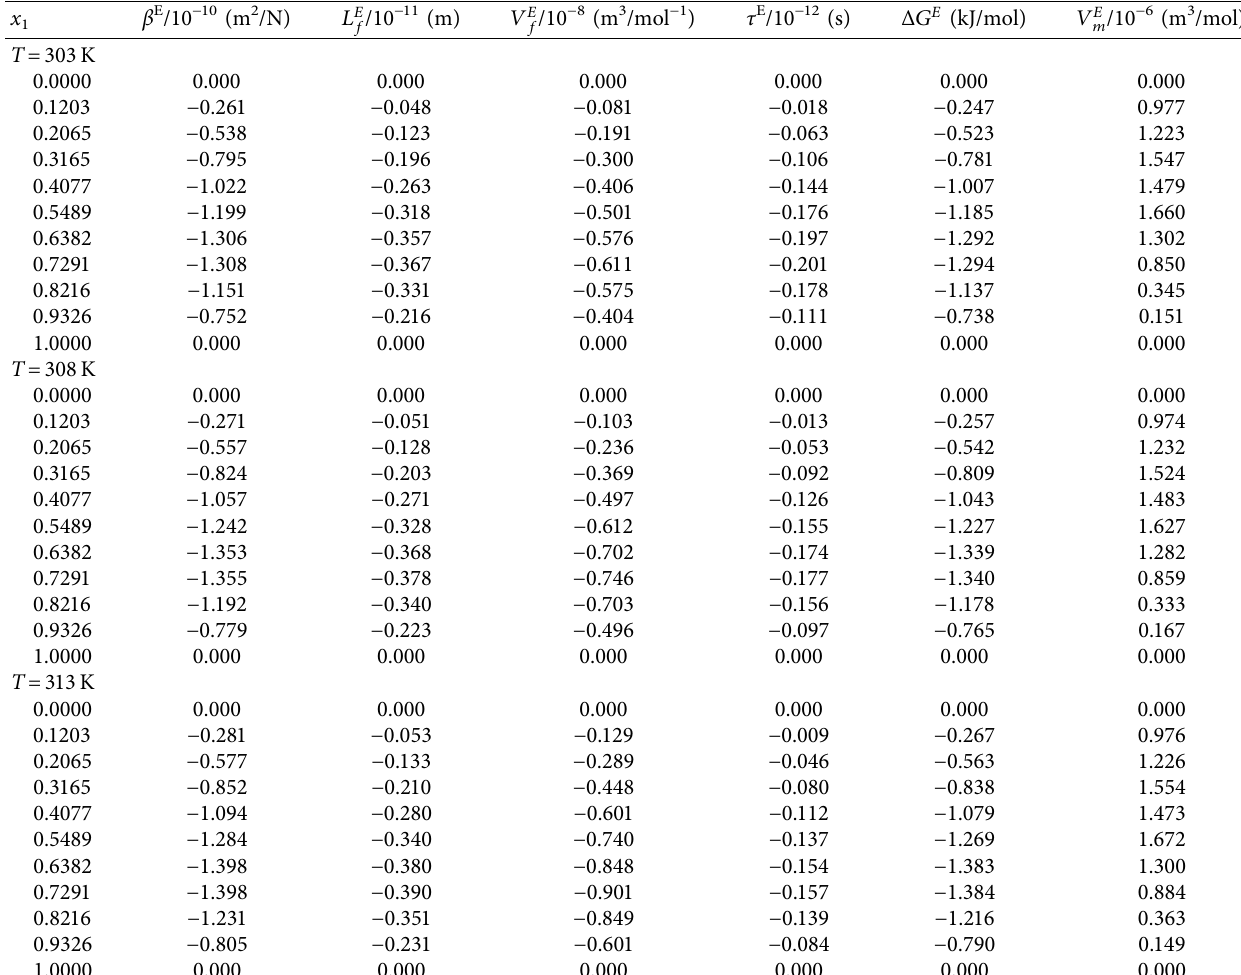
Figure 2: Variation in Gibbs free energy with mole fraction of chlorpheniramine and 1-propanol at 303 K, 308 K, and 313K in the atmospheric pressure. Table 3: Excess values of chlorpheniramine with 1-propanol at 303K, 308K, and 313K in the atmospheric